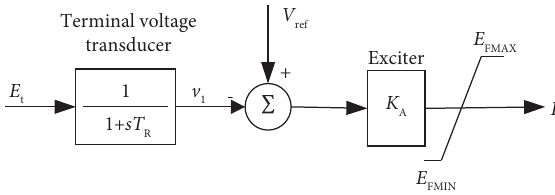
Figure 5: Tyristor excitation system with